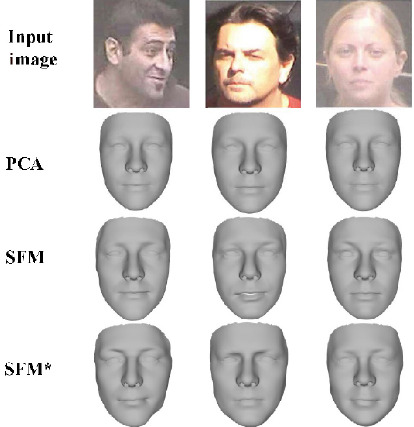
Fig. 6 Ablation experimentation samples from MICC [71] dataset. PCA is the PCA-based model using the same 3D face dataset as SFM. SFM* is the SFM finetuned with 2D data.